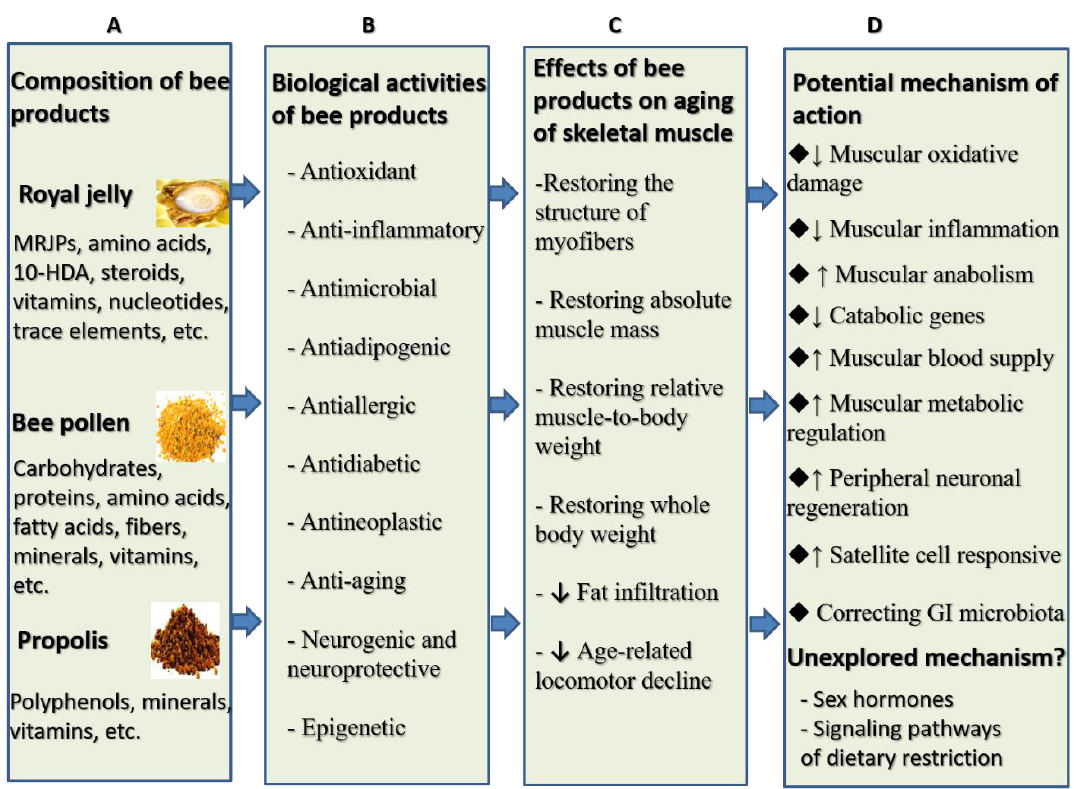
Figure 1. Brief summary of the chemical composition and biological activities of royal jelly, bee pollen, and propolis along with their e ff ects on aged skeletal muscle and possible underlying mechanism. ↑ denotes increase, ↓ denotes decrease, MRJPs: major royal jelly proteins, 10-HDA: trans-10-hydroxy-2-decenoic acid, GI: gastrointestinal. Panels ( A , B ) describe the composition and the biological properties of royal jelly, bee pollen, and propolis. Thanks to their rich structure (which consists of proteins, polyphenols, vitamins, minerals, and trace elements) [2,28,37,49,59–61,68,80,86], these bee substances demonstrate a wide range of therapeutic activities such as counteracting inflammation e ff ects of royal jelly, bee pollen, and propolis on skeletal muscle. These products increased